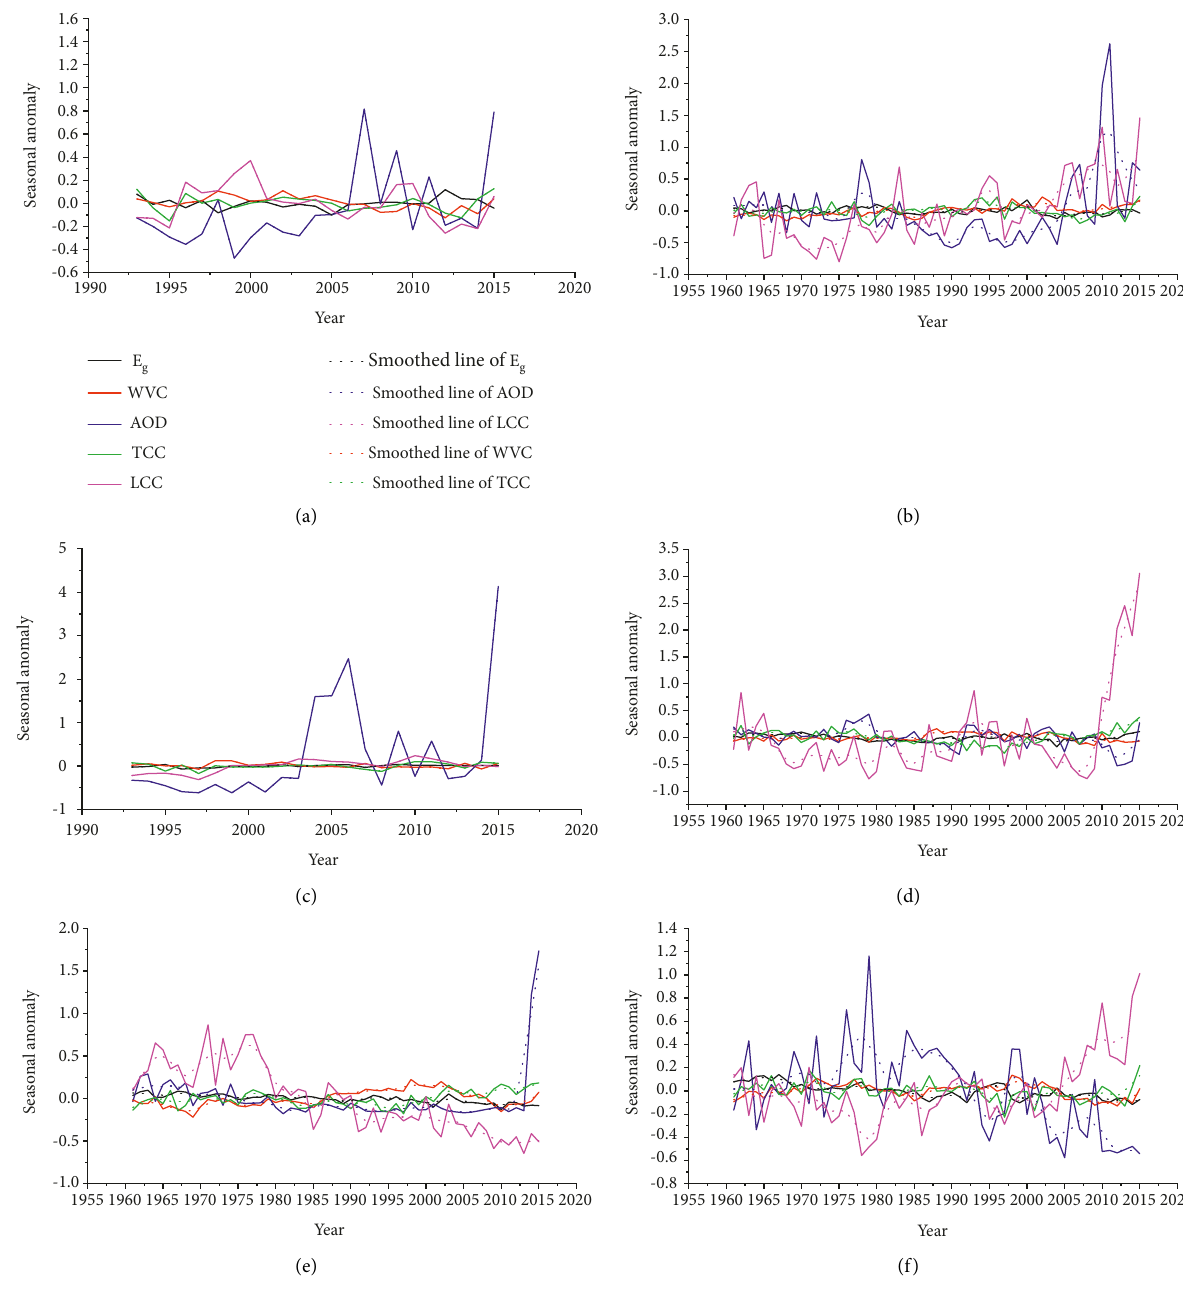
Figure 5: Interannual variations in anomalies of E Lowess algorithm (dashed lines) observed at the (a) Yining, (b) Ruoqiang, (c) Urumqi, (d) Hetian, (e) Hami, and (f) Turpan stations in